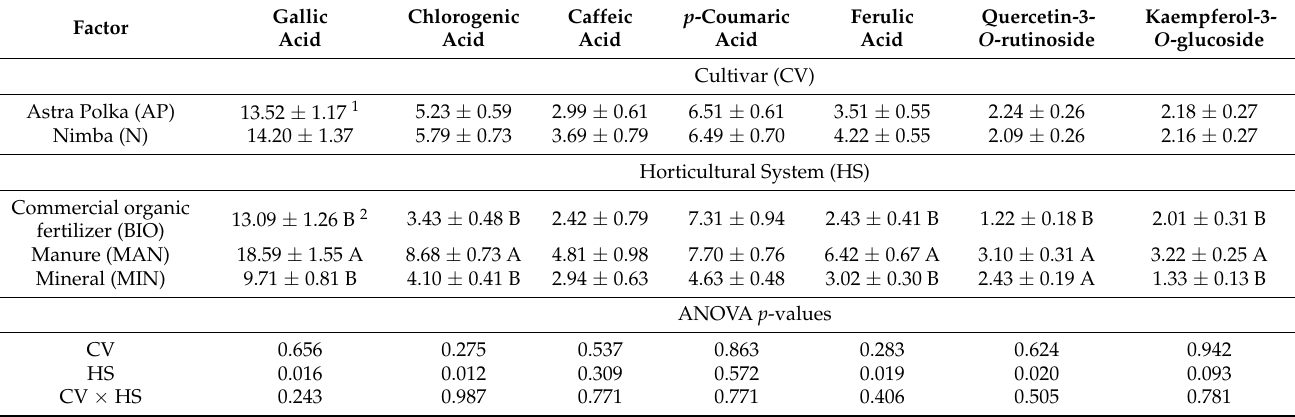
Table 4. The main effect of, and interactions between, cultivar and horticultural system on the content of individual phenolic acids and flavonoids ( µ g/g f.w.) in courgette